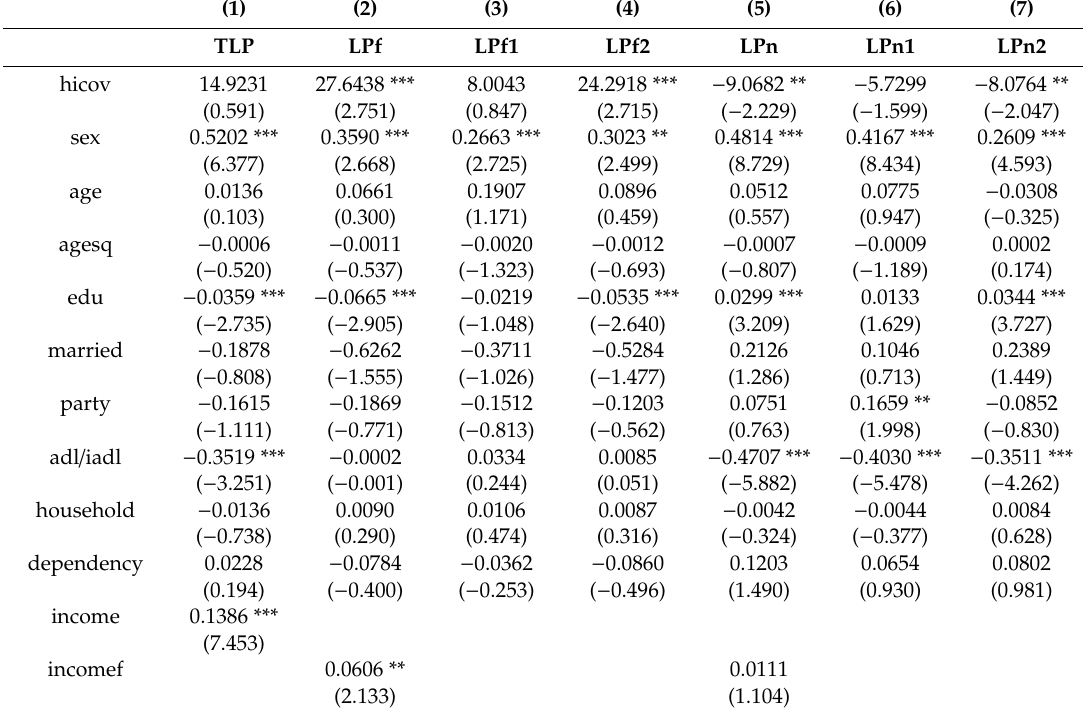
Table 7. Estimation of labor participation model in medical insurance